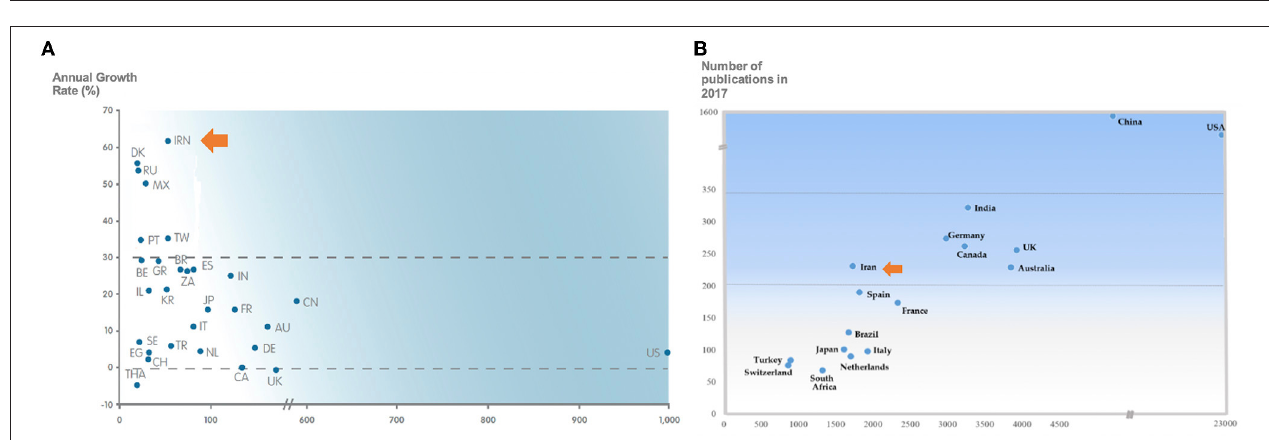
FIGURE 2 | The average percentage of graduates of Engineering, Manufacturing and Construction programs, both sexes (%) 1999–2013 (Data Source: World Economic Forum and UNESCO Institute for Statistics).